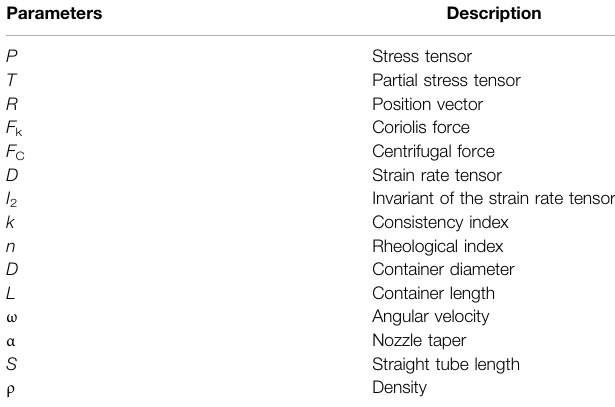
TABLE 2 | The parameters used in the formula and